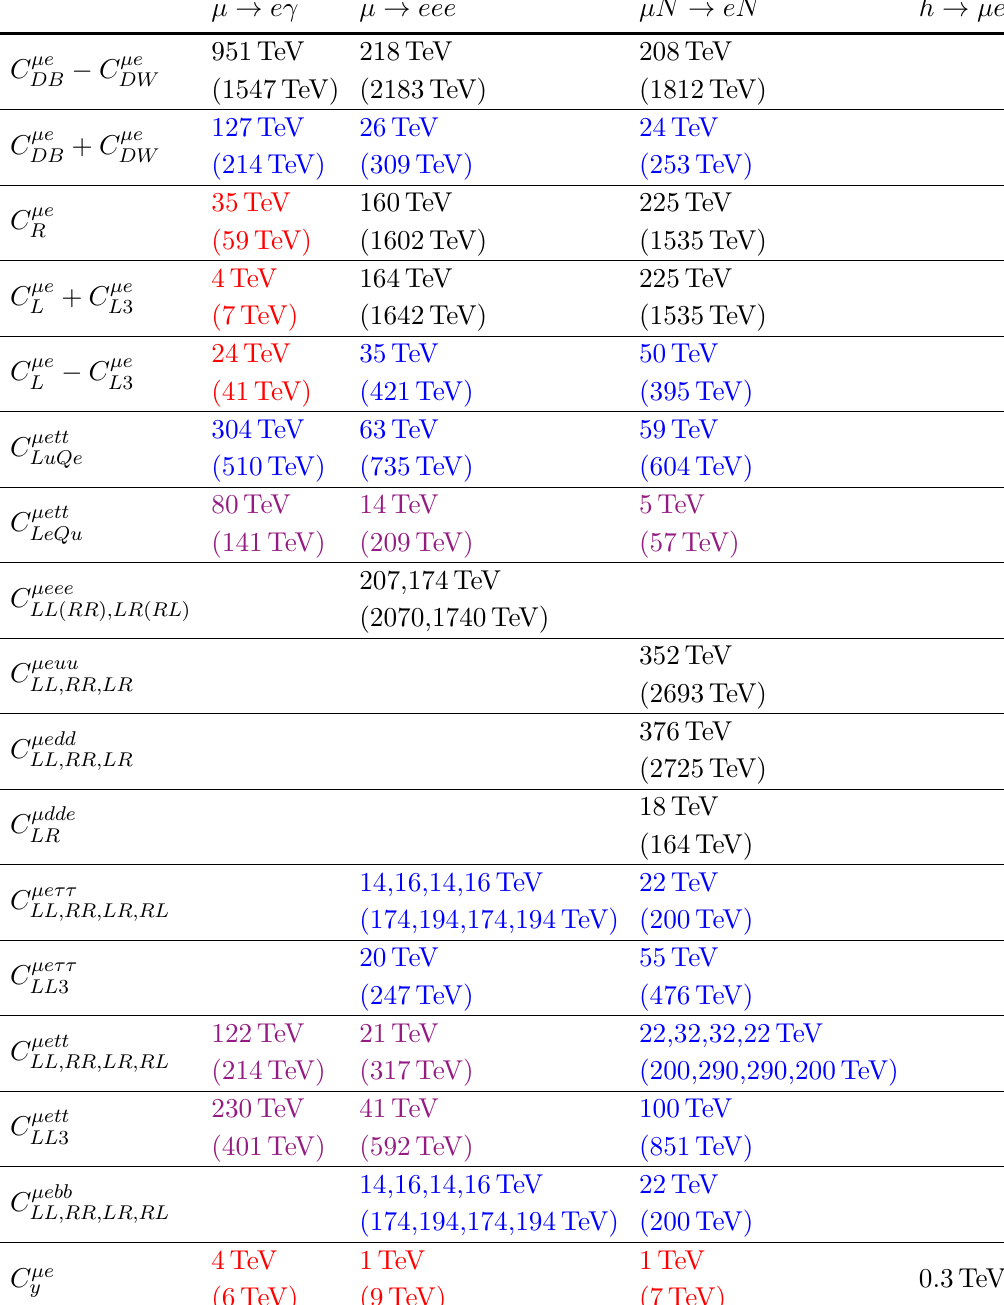
Table 2 . Present (future) lower bounds on Λ of the dimension-six operators (2.2)–(2.5) from the different LFV violating processes. We have fixed the Wilson coefficient C i = 1 , turning each one by one. We show the bound in black, blue, purple and red depending on whether the Wilson coefficients contribute to the observables at the tree-level, one-loop single-log, two-loop double-log or two-loop single-log order, respectively. Blank spaces correspond to contributions that we estimate to be too small to be competitive with existing